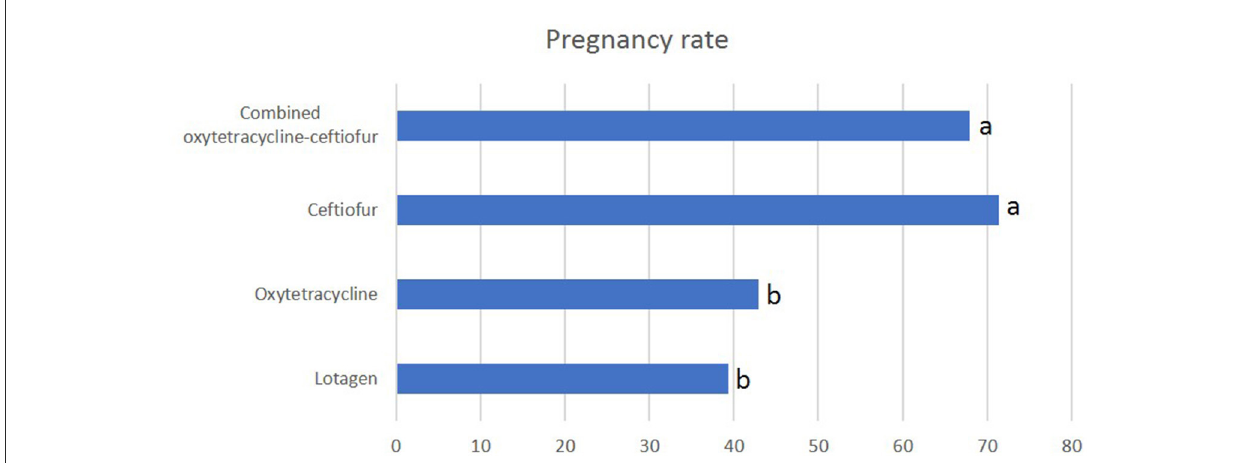
FIGURE3 Service per conception in different protocols used for the treatment of endometritis in dromedary camels. Service per conception was calculated by the number of estrus periods during which mating took place. Columns with different letters indicate a significant difference ( P <